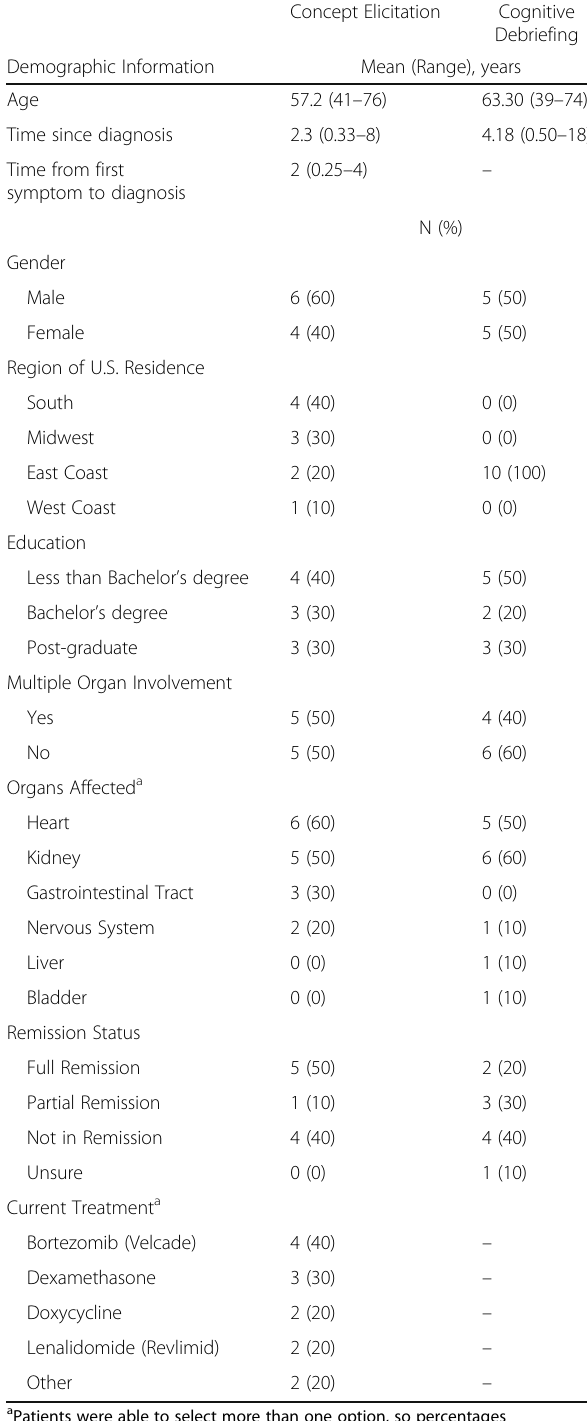
Table 2 Patient demographic